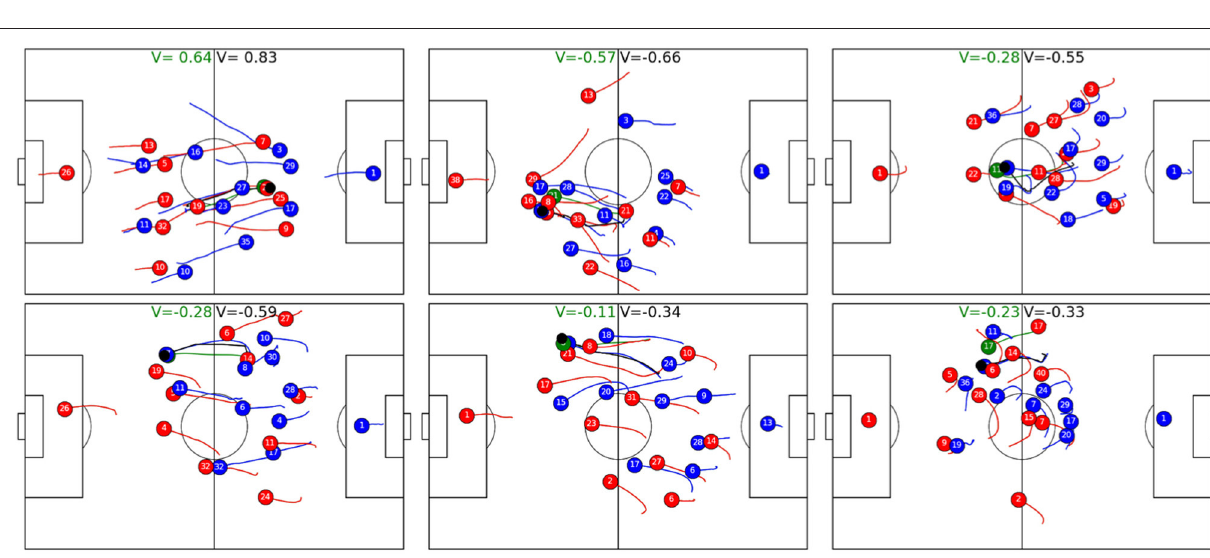
FIGURE 9 | Simulated and observed trajectories of midfielders (Top) and wingers (Bottom) with the largest difference between observed and simulated V. The simulation starts 8 frames (0.32 s) after the opponent gaining possession of the ball and spans 4 s. Simulated players are depicted in green and V with simulated players are also labeled in green. In all cases, simulated players immediately tracked back after a loss of ball, whereas observed players either did not track back at all or reacted too late. The simulated player lost the ball in panels 1 (23, blue), 2 (21, red), 3 (11, red), and 4 (14, red). In panel 5, red player 21 lost the ball and 8 of red is simulated, whereas in panel 6, blue no. 12 (partly occluded) intercepted a pass and red no. 17 is